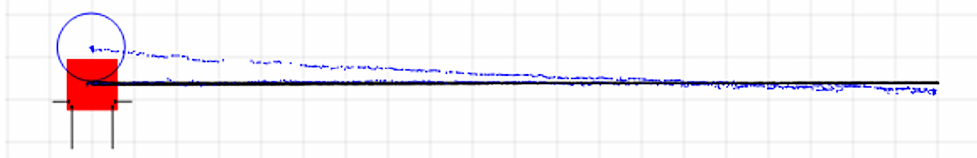
Figure 13. Result after applying the lateral translation and translation–rotation correction factors obtained by the IPS.